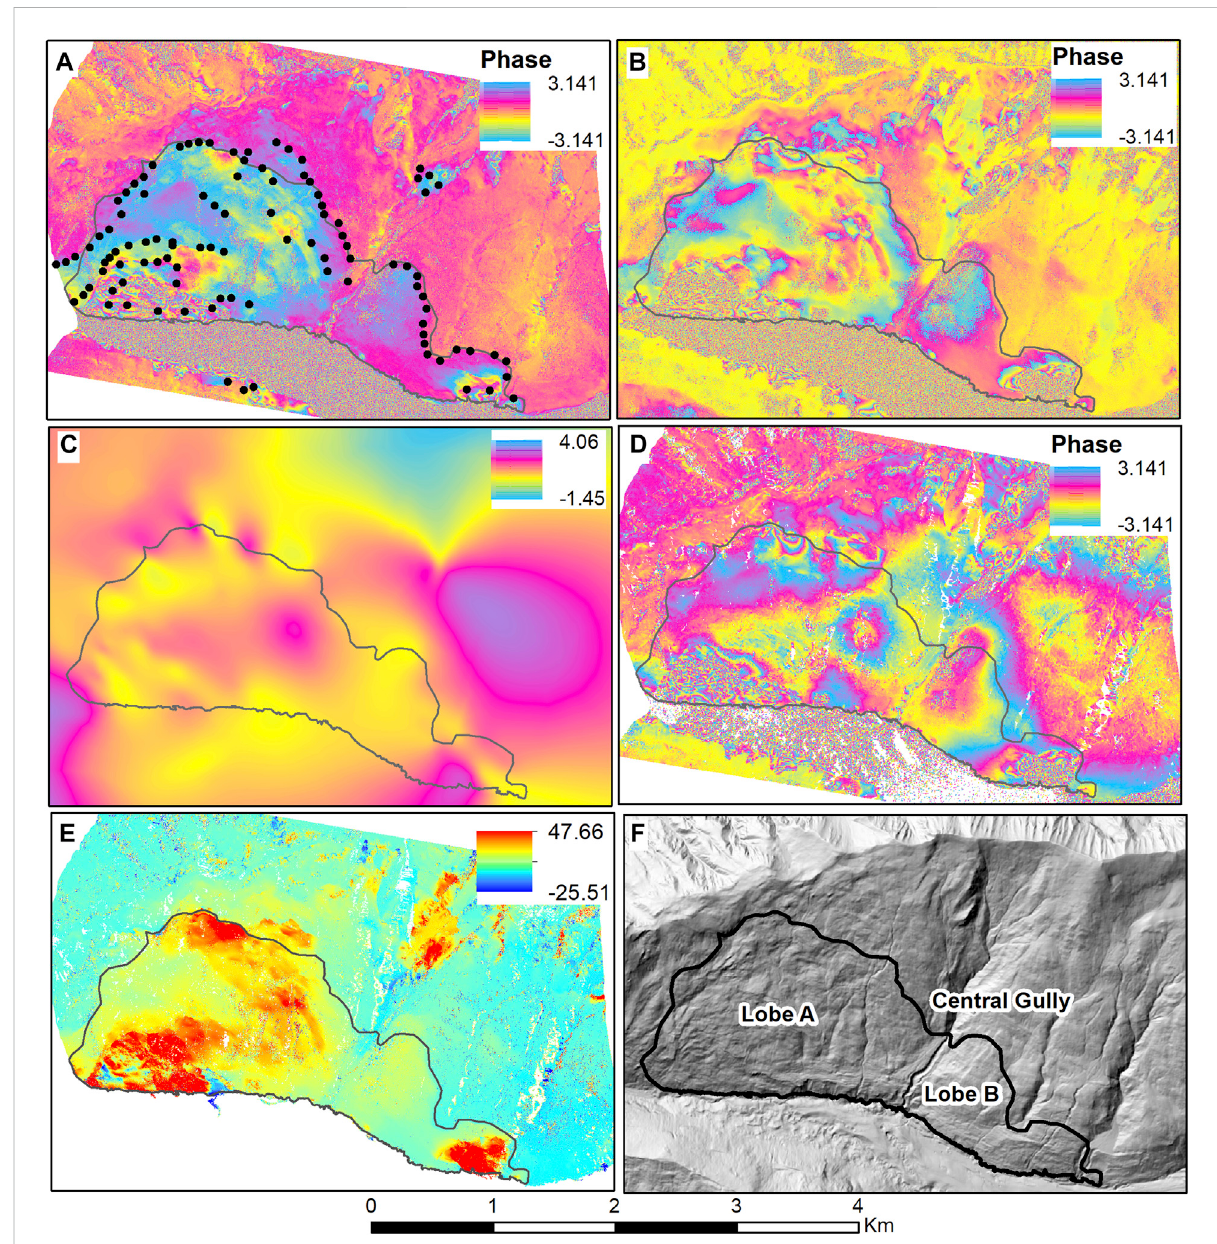
FIGURE 5 The process of phase demodulation (black outline encloses themain active area of the complex composite DSGSD of Fels slide). (A) Reference interferogramandthegridofpatches(blackpoints)straddlingphasediscontinuitiesandstrongphasegradients. (B) RADARSAT-2interferogramtobe unwrapped using the phase demodulation approach. (C) Match factor surface derived from the RADARSAT-2 interferogram to be used to minimize phasegradients. (D) Reference phasescaledusingthephasematchfactor, resultinginasmoothresidual phasesurfacethatcan beunwrapped. (E) Unwrapped residual phase added to the unwrapped reference phase to produce the fi nal unwrapped phase. (F) Hillshaded DEM showing outline of the active landslide with main lobes